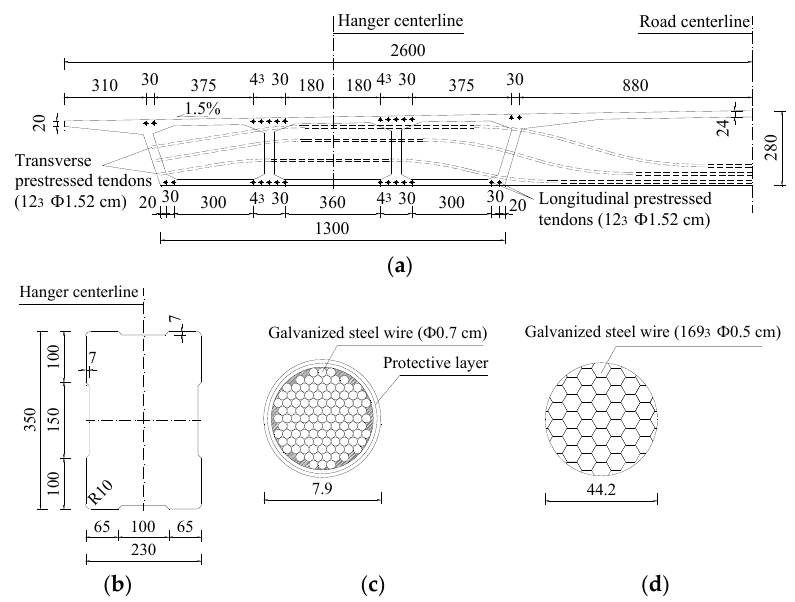
Figure 3. Cross section of key component: ( a ) Main girder; ( b ) Tower; ( c ) Hanger; and, ( d ) Cable (Unit: cm).